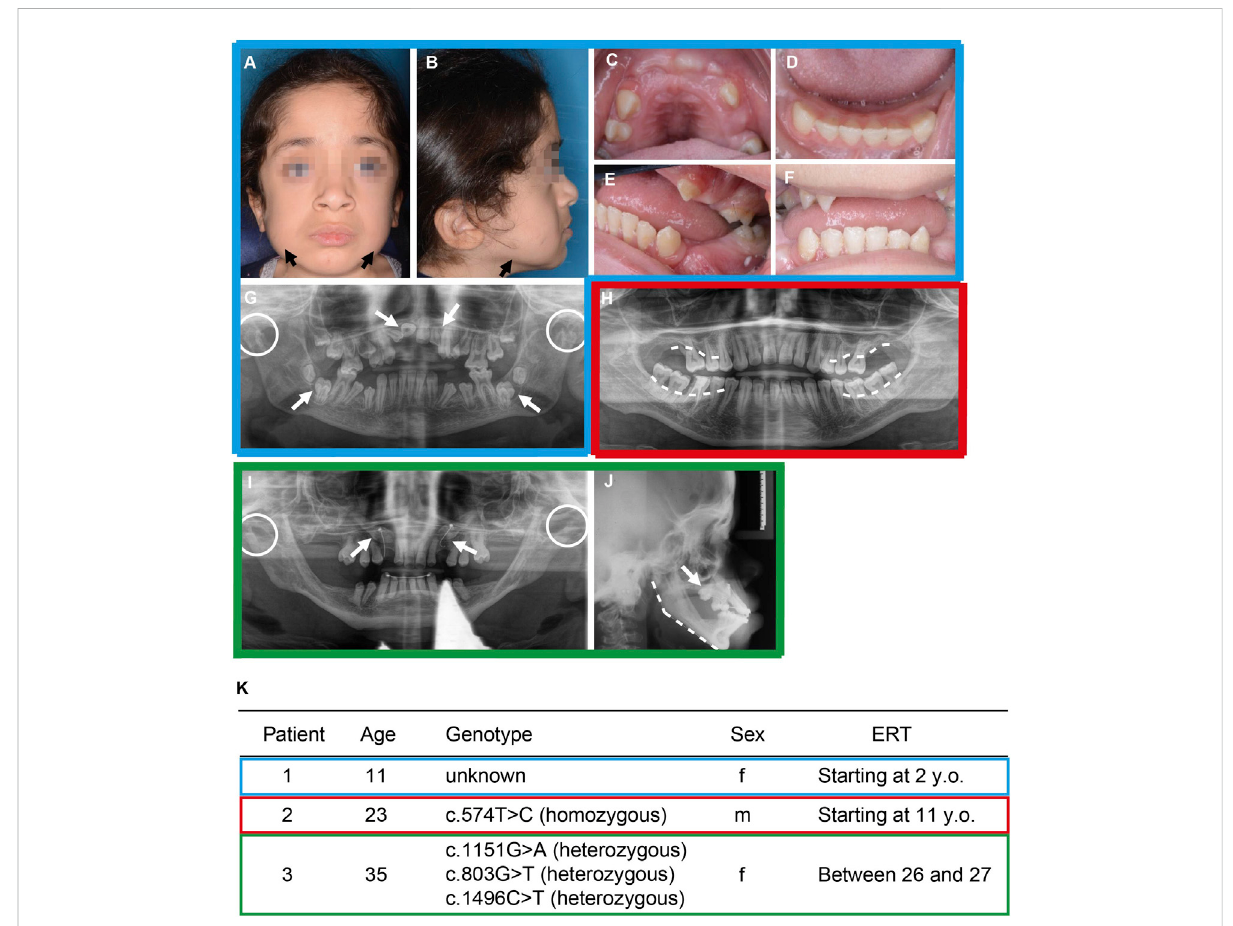
Craniofacial and dental pathologies of patients with Mucopolysaccharidosis Type VI. (A – G) Patient #1 at 11 years treated with ERT (Naglazyme, BioMarin Pharmaceuticals) starting from the age of 2. (H) Patient #2 at 23 years treated with ERT starting at the age of 11 years. (I – J) Patient # 3 at 35 years treated with ERT between the age of 26 and 27. (A – B) Extraoral photographs display the MPS VI – typical facial coarsening with mandibular bone exostoses atthe jawline (black arrows). (C – F) Intraoral photographs show gingival hyperplasia and delayed anterior teeth eruption, which normallyeruptsintheagebetween6and9 years. (G) Panoramicradiographimageshowingdisplacedandretainedincisorsanddentigerouscystsof the fi rstmandibularmolars(whitearrows).Bleedingonprobingwasobservedinperiodontalscreenings.Furthermore,condylarhypoplasiaismarked with white dotted circles. (H) Panoramic radiograph image reveals progressive maxillar and mandibular horizontal bone loss (white dashed lines). In periodontalscreenings,probingdepthsover6 mmweremeasured.Teeth37and47wereextracted afterwardduetoincreasedmobility.Mandibular condyles are not shown in this image. (I) Panoramic radiograph image showing retained cuspids and orthodontic traction chains (white arrows). Condylar hypoplasia is marked with white dotted circles. (J) Lateral cephalometric radiograph displaying severe vertical facial growth including fl at mandibular angle (white dashed line). Retention of the cuspids is shown from a lateral view (white arrow). (K) General information of the three patients including genomic modi fi cation within the ARSB gene. Here, (C) 574T > C, corresponding to p. C192R, and (C) 1151G > A (p.S384N) are pathological (Lin et al., 2008; Tomanin et al., 2018). The mutation (C) 1496C > T (p.L499P) is probably also pathological, since an L498P substitution impairs the a-helix structure of ARSB and thus probably its function. (Litjens et al., 1996). However, we additionally identi fi ed a previously unknown mutation c803G > T (p.G268V), which was not previously described in the literature (Panel